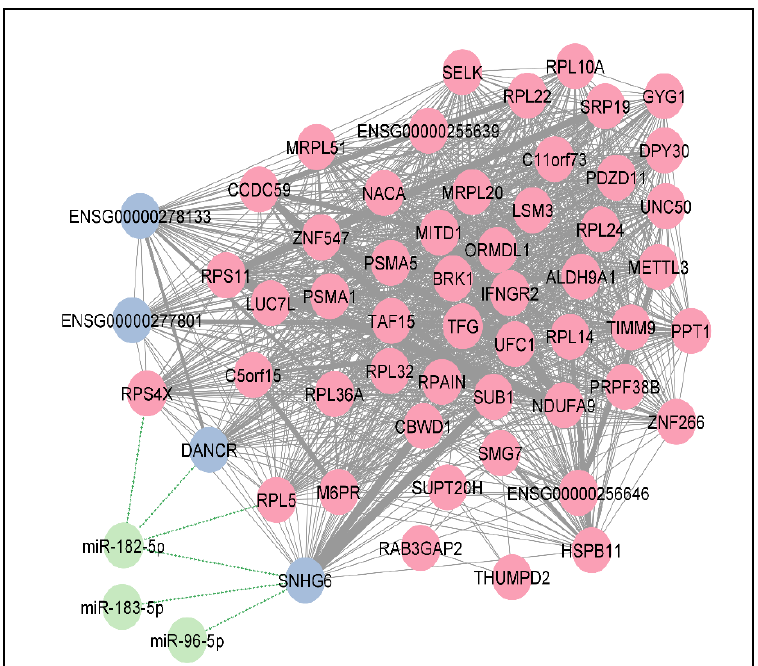
Figure 4. The DANCR/SNHG6 sub-cluster of DElncRNA-DEPCG (blue and pink circles, respec- tively) co-expression correlation network produced was visualized using MCODE in Cytoscape, supplemented with interacting DEmiRNAs (green circles) as supplied by mirTarBase and LncBase databases. STRING enrichment analysis of this sub-cluster shows strong similarity with DEPCG enrichment, thereby denoting sub-cluster relevance.